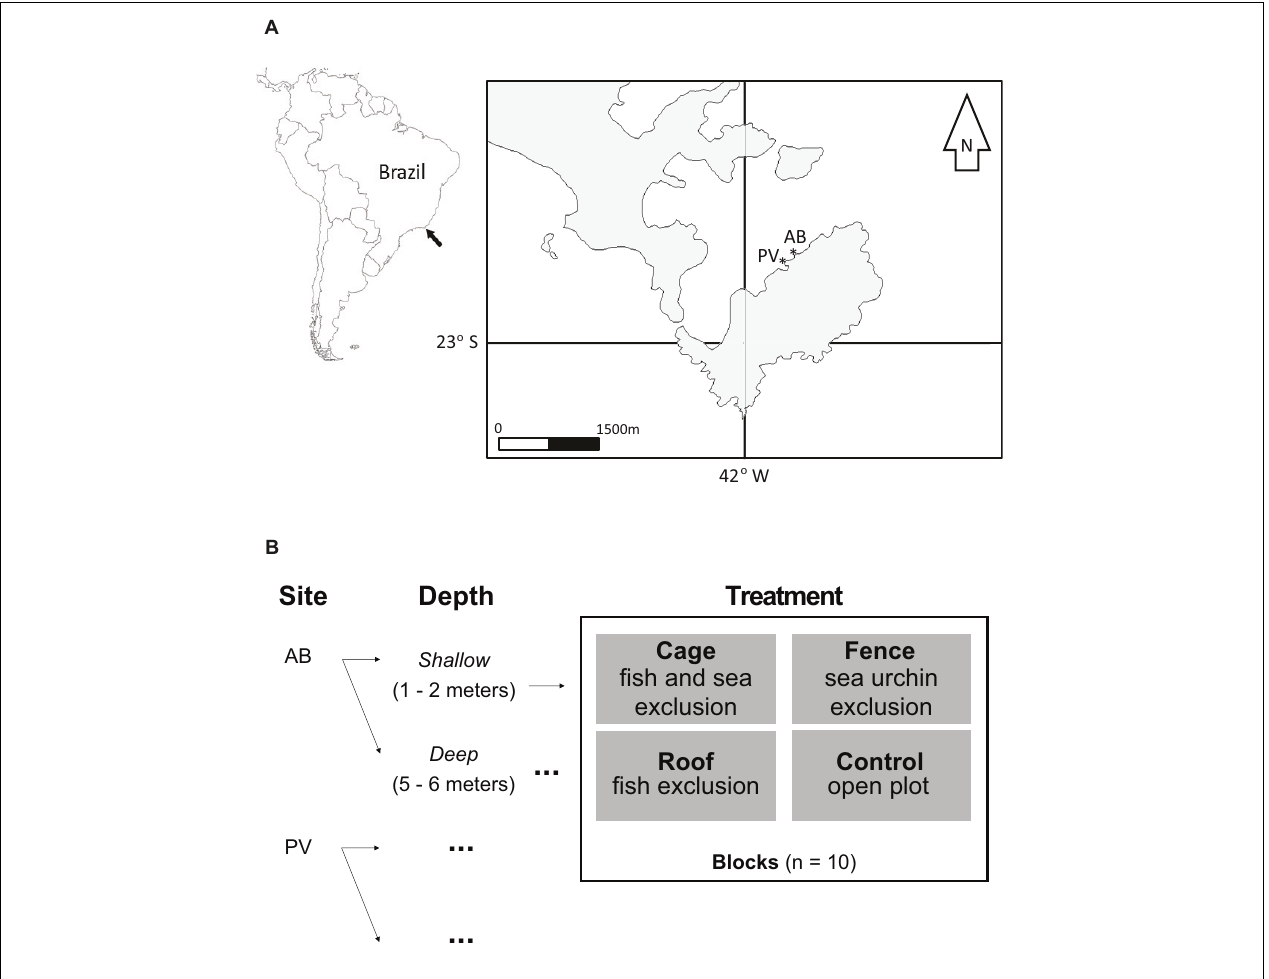
FIGURE 1 | (A) Map of Arraial do Cabo region (RJ, Brazil). The asterisks in the figure on the right show the experimental sites. (B) Experimental design schema indicating levels of factors, treatments and replication applied-images of treatments are available in the Supplementary Material . AB – Abobrinha (22.985 ◦